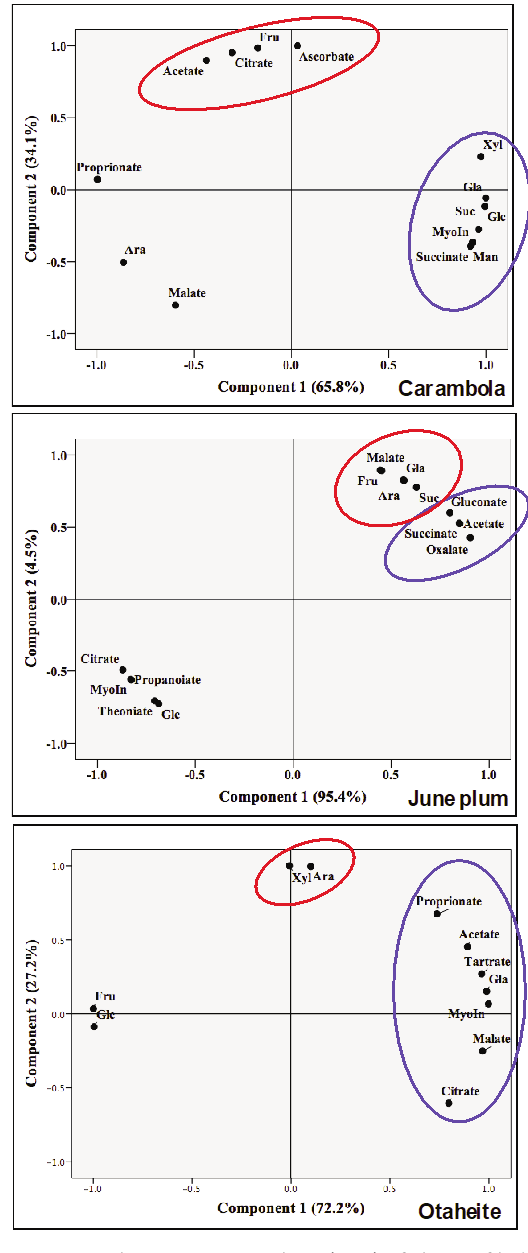
Fig. 2 ­ Principal component analysis (PCA) of the profiled and identified metabolites in carambola, June plum and otaheite fruits through different development and ripe­ ning stages. For PCA analysis, data sets were normalised for better comparison of the variable levels of the diffe­ rent